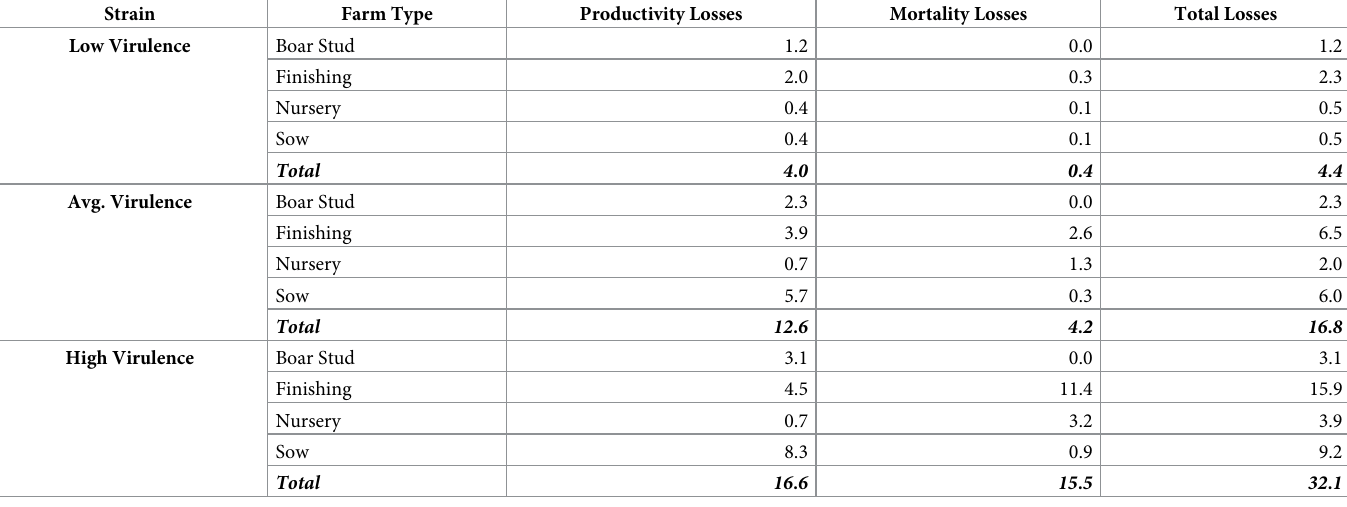
Table 4. Estimated losses from an uncontrolled PRRS outbreak ( USD millions ), by viral strain and farm type.